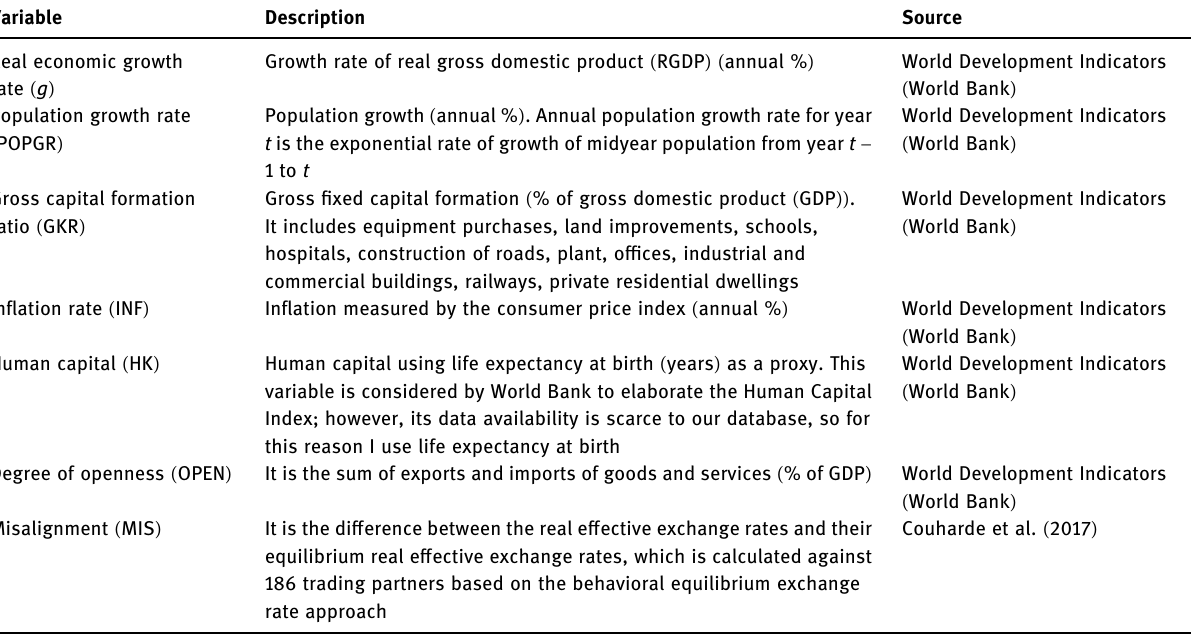
Table A1: De fi nition of the explanatory variables in the panel regression and data sources